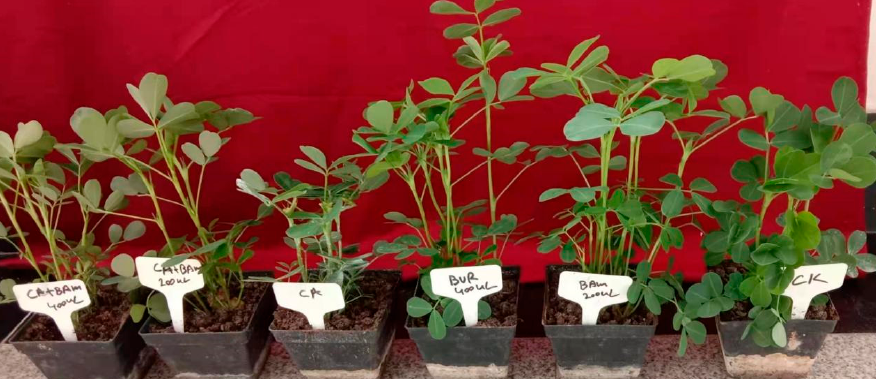
Figure 6. An illustration of the pot experiments on the growth of peanut plants by the effects of BAM strain. Ck (no treatment); BAM 200 μ L and BAM 400 μ L (treatment with fermentation broth of BAM strain); CA (inoculated with Circospora arachidichola ); CA + BAM 200 μ L and CA + BAM 400 μ L (treatment with fermentation broth of BAM strain). BAM strain significantly triggered the physiological parameters of peanut plants un- der the biotic stress of C. arachidichola and without biotic stress. The dose of BAM at 400 uL significantly influenced the photosynthesis rate, transpiration rate, stomatal conduct- ance, and sub-stomatal CO 2 concentration (163.78 ± 1.99 μ mol CO 2. m − 2.s − 1 , 168.00 ± 5.45